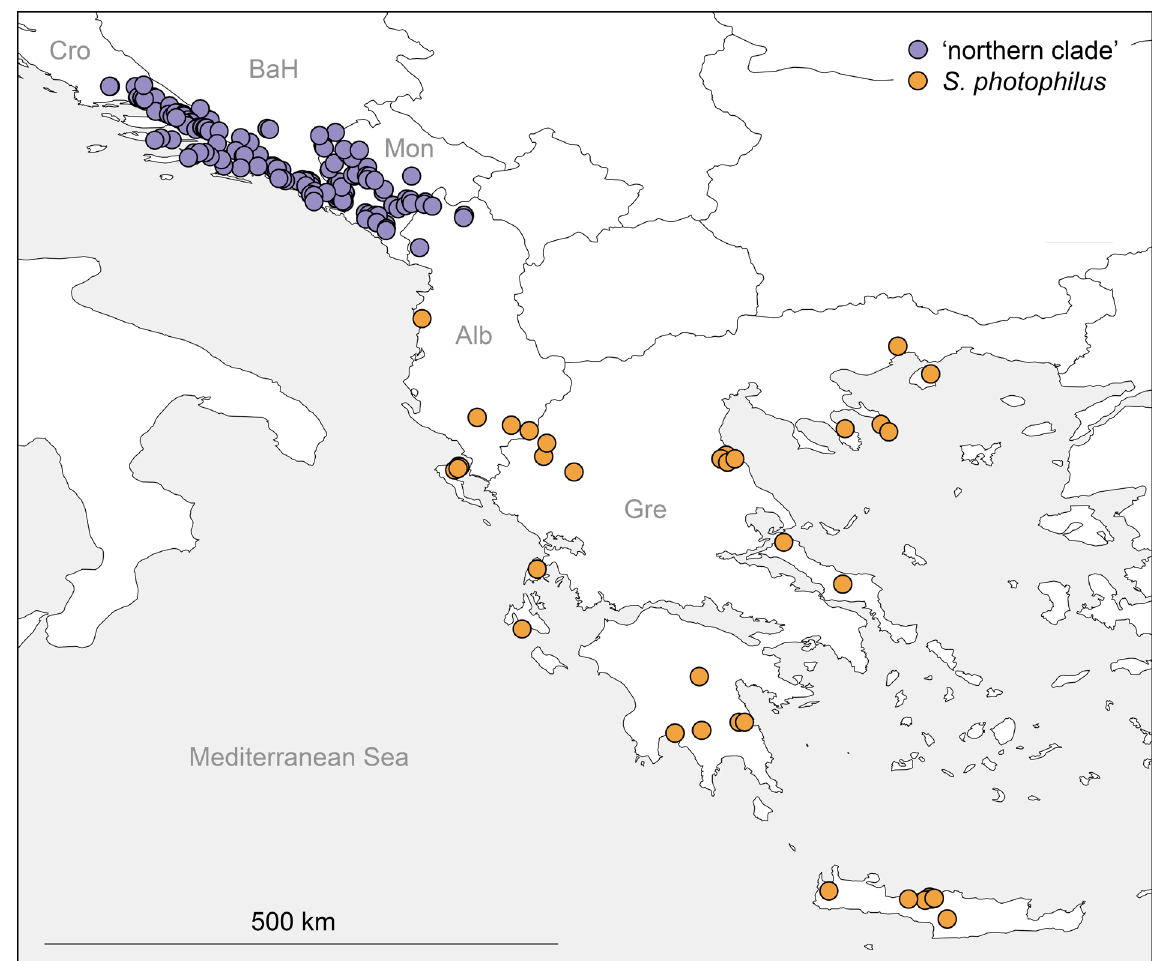
Fig. 167. Known distribution of Stygopholcus Kratochvíl, 1932. For the ‘northern clade’, see Fig. 168. Abbreviations: Alb = Albania; BaH = Bosnia and Herzegovina; Cro = Croatia; Gre = Greece; Mon =